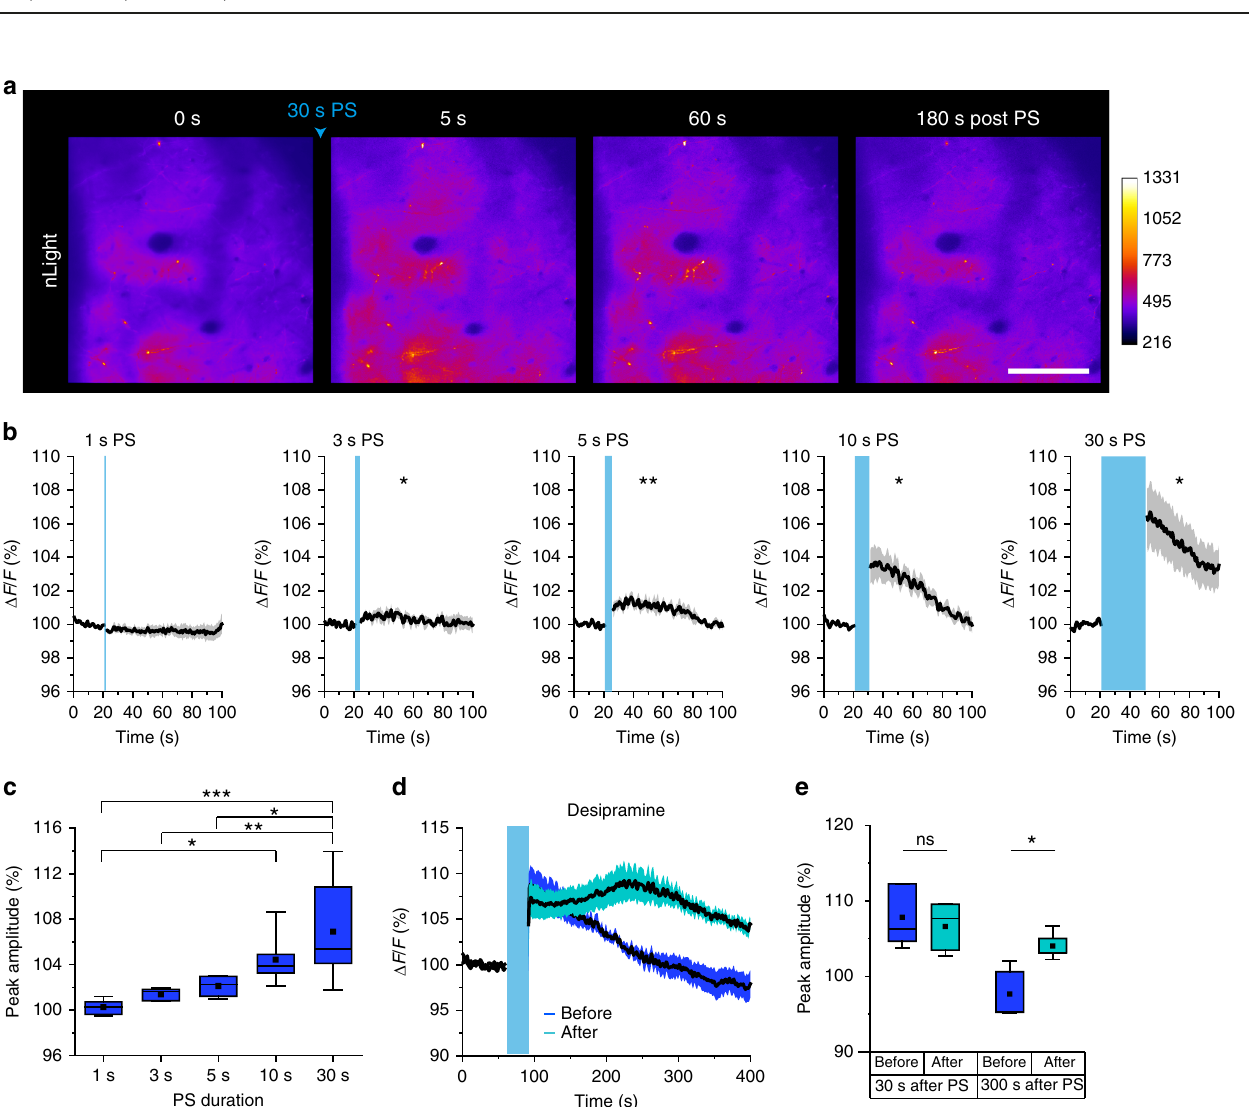
Fig. 1 Ca 2 + and cAMP responses of cortical astrocytes to noradrenergic afferent activation. a Illustration of virus injections. This image was adapted from Allen Mouse Brain Atlas. b EYFP in LC neurons 3 weeks after AAV delivery (green). LC is visualized by tyrosine hydroxylase (TH) immunohistochemistry (red). VTA: ventral tegmental area. c Magni fi ed images of LC. d Innervation of LC NAergic neurons in the cerebral cortex. e EYFP- labeled LC-neuronal NAergic fi bers overlap with TH + fi bers in the cortex. f Virtually all TH + cells express EYFP in the LC ( n = 5 images, 5 mice). g Unilateral AAV microinjection to the LC labels 50% of TH + fi bers in the cortex ( n = 4 images, 3 mice). h , i Astrocytic Ca 2 + and cAMP responses to optogenetically activated NAergic axons in the cortex with 5-s PS ( h ) and 30-s PS ( i ). j , k Average Ca 2 + and cAMP responses of cortical astrocytes to varying NAergic fi ber photostimulation (PS) length. l , m Individual cell responses are plotted and sorted by response amplitude. n , o Astrocytic Ca 2 + activity analyzed by peak amplitude ( n ) ( n = 208, 194, 139 cells, 144 cells) and active astrocytes ( o ) ( n = 6 – 7 sessions, 5 mice). p , q Astrocytic cAMP activity analyzed by peak amplitude ( p ) ( n = 161, 87, 142, 186 cells) and active astrocytes ( q ) ( n = 5 – 6 sessions, 6 mice). r – u Pharmacological dissection of LC/NA axon-evoked astrocytic Ca 2 + and cAMP. Representative images of GCaMP and Pink Flamindo with prazosin or propranolol application ( r ). Comparison of GCaMP ( s ) and Pink Flamindo ( t ) signals after prazosin or propranolol application. Pink Flamindo responses after betaxolol or ICI 118,551 application ( u ) ( n = 4 mice for all plots). Analysis was performed from individual cells for n and p and from averages of individual sessions for the others. All astrocyte responses represent somatic signals hereinafter unless otherwise noted. Scale bars: b , 500 μ m; c , d , h , i , 100 μ m; r , 50 μ m; e , 10 μ m. Bar graphs: mean + SEM. Box plots: box range, 25 – 50 – 75% quatile; square, mean; whiskers, max – min. One-way ANOVA with Turkey ’ s test: n – q ; paired t -test: s – u ; * p < 0.05, ** p < 0.01, *** p < 0.001.